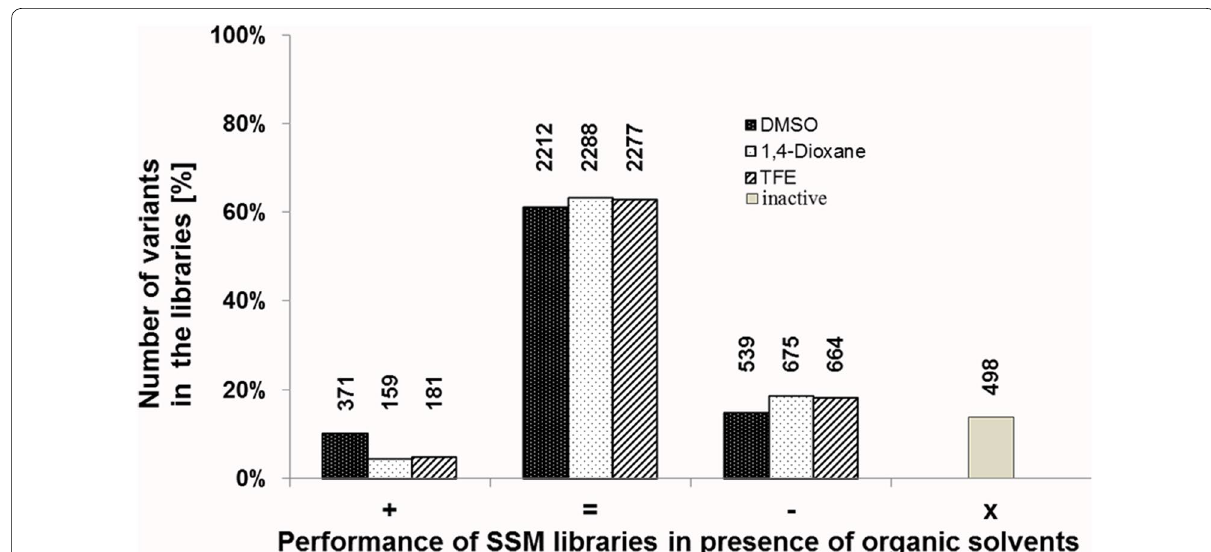
Fig. 2 Number of SSM‑BSLA variants which lead to improved/unchanged/decreased organic solvent resistance and inactivation of BSLA in buffer. : variants with improved resistance; +